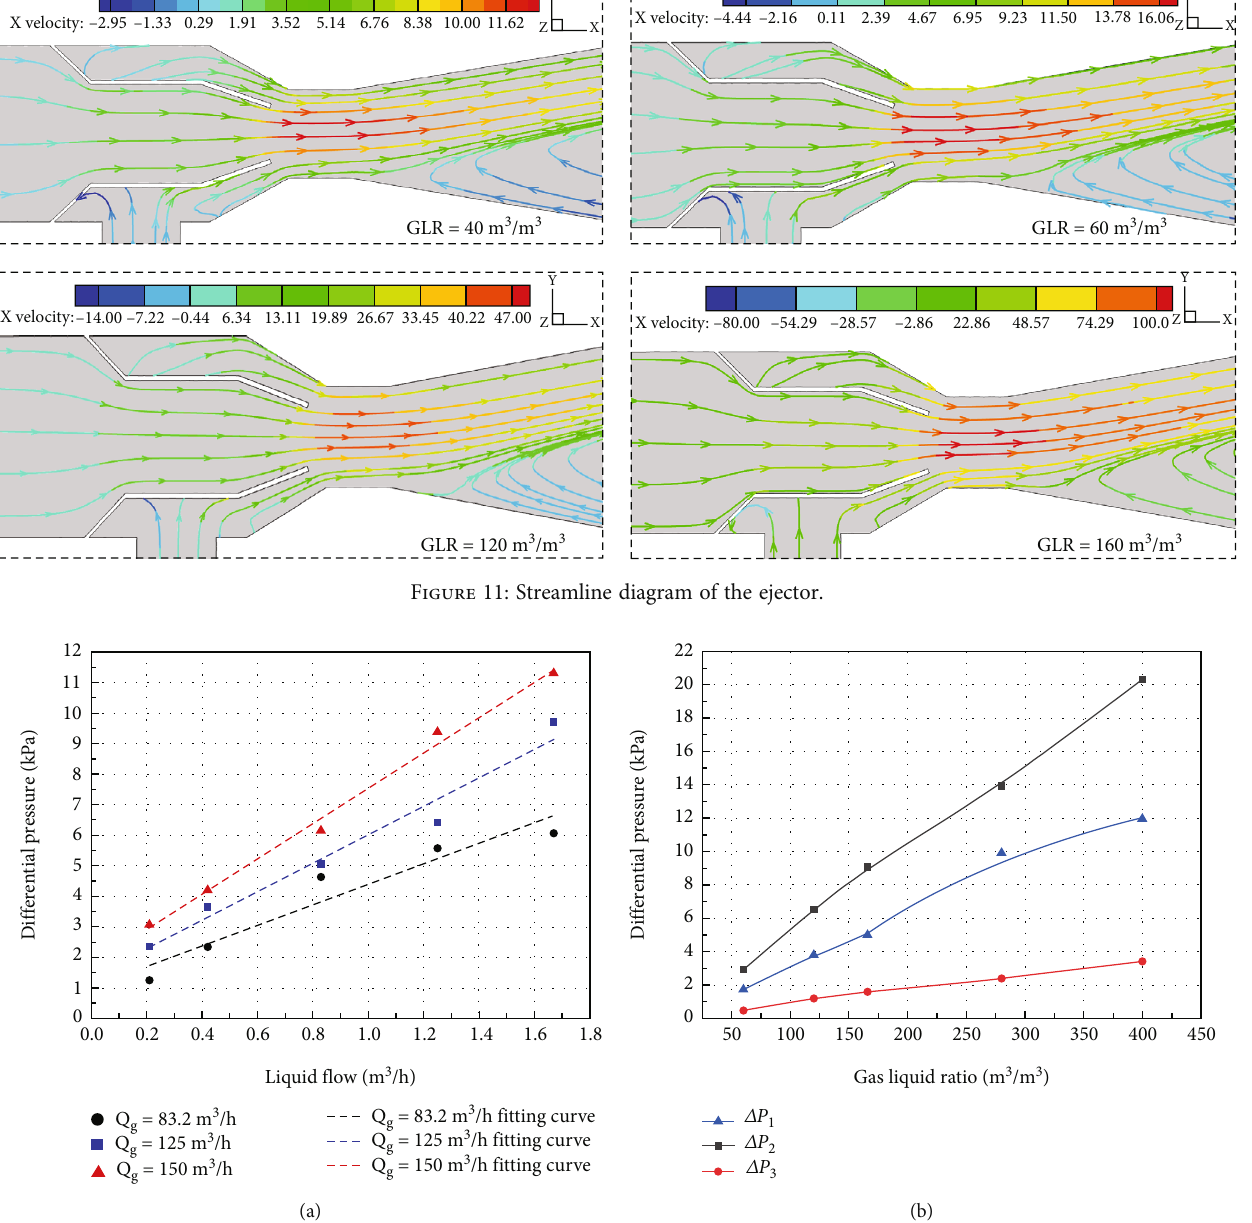
Venturi-tapering section, Δ P Venturi-expansion 2 3